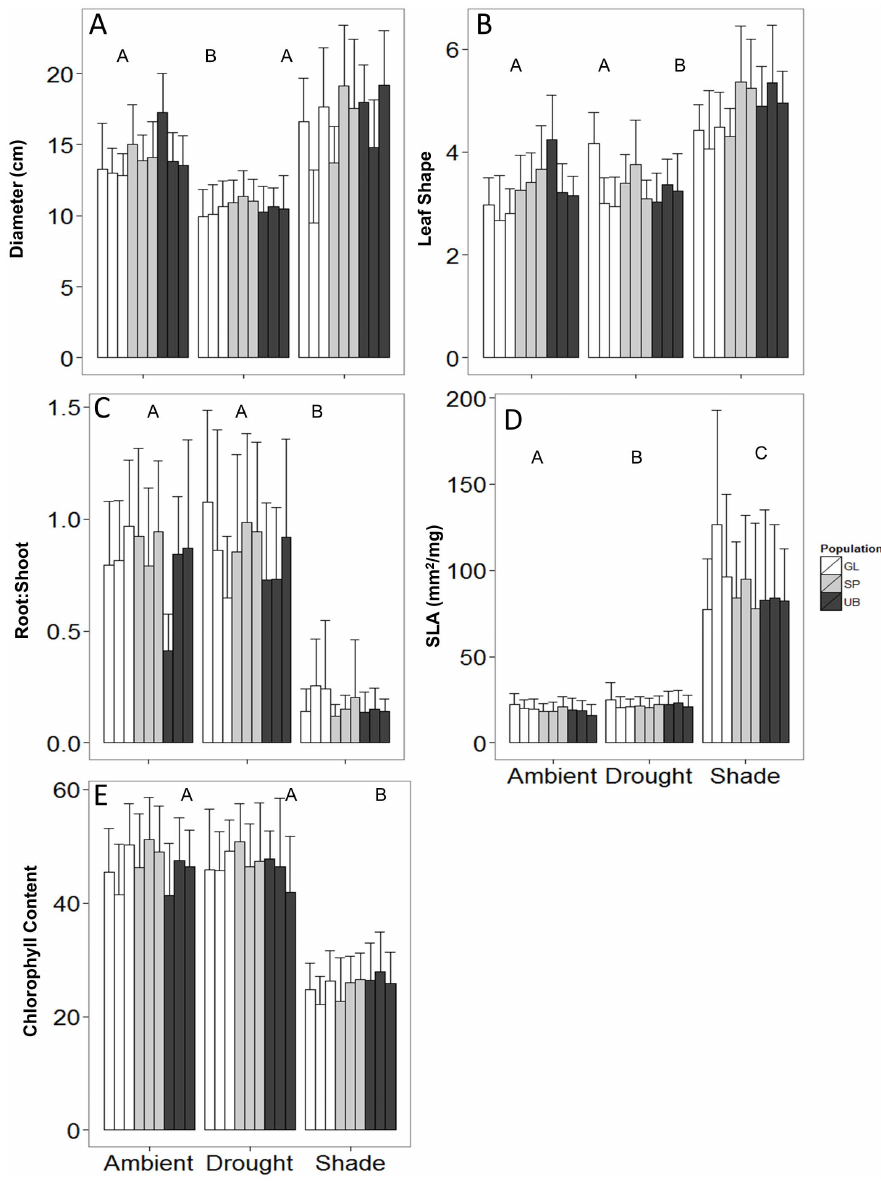
Figure 2. Mean ( + SD) values of A) final diameter, B) leaf shape (length:width ratio), C) root:shoot ratio, D) SLA, and E) final relative chlorophyll content for each maternal line (individual bar, arranged from low to high based on scores from PC1) in each population (unique color; defined in Table S1) for each treatment. Significant treatment differences ( a =0.05) in trait means are indicated by different letters.